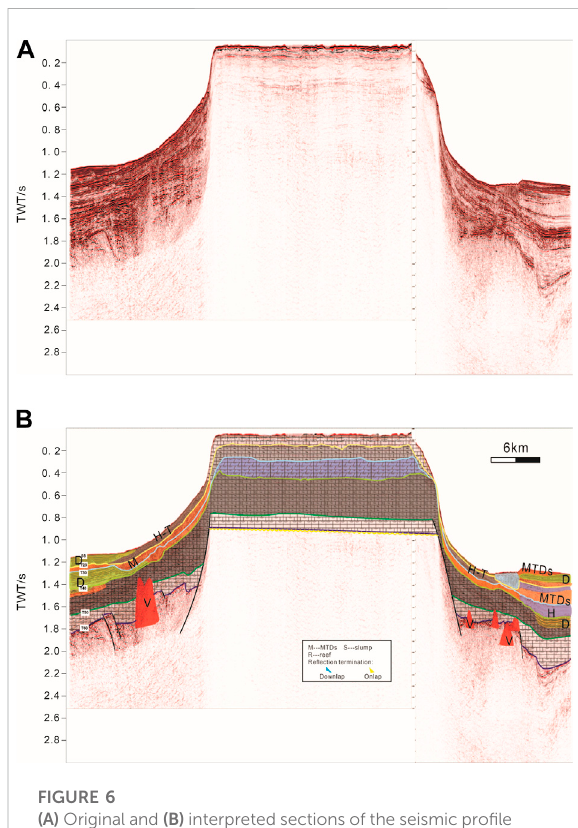
FIGURE 6 (A) Original and (B) interpreted sections of the seismic pro fi le XDS10.